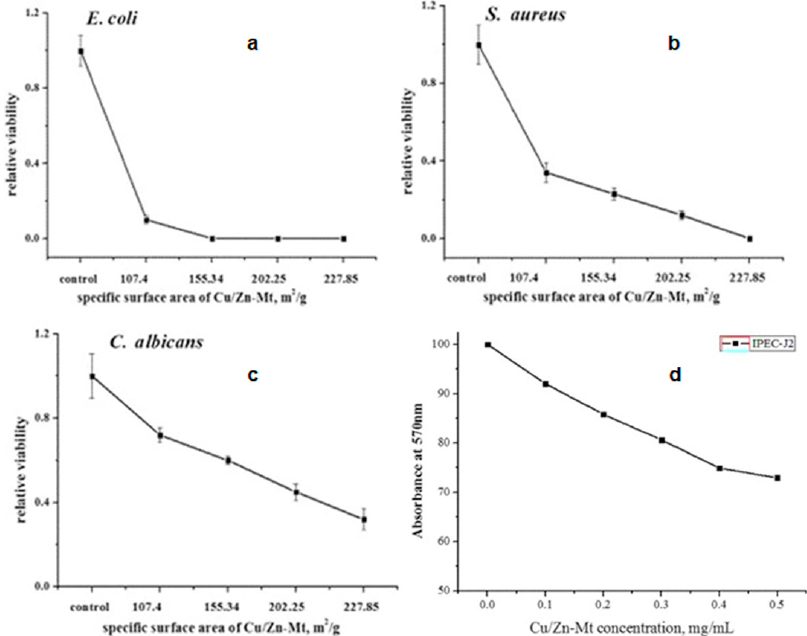
Figure 6. ( a – c ) The antimicrobial activity of Cu/Zn-MMT-2 with different specific surface area, ( d ) the cytotoxicity of Cu/Zn-MMT. Adapted from [229], BMC part of Springer Nature, distributed under the terms and conditions of the Creative Commons Attribution (CC BY) license.